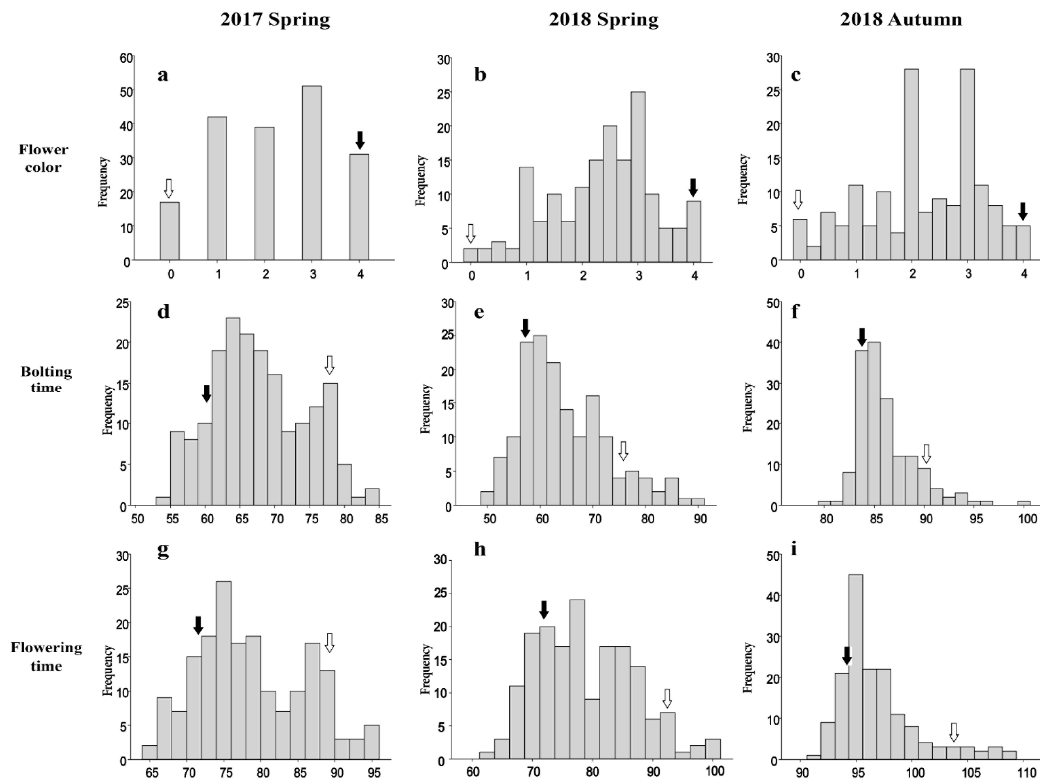
Figure 2. Frequency distribution of the flower color, bolting time, and flowering time traits in radish populations over two years. ( a , d , g ): frequency distribution of the flower color, bolting time, and flowering time for the F 2 population in spring 2017; ( b , e , h ): frequency distribution of the flower color, bolting time, and flowering time for the F 2:3 population in spring 2018; ( c , f , i ): frequency distribution of the flower color, bolting time, and flowering time for the F 2:3 population in autumn 2018. The trait frequencies were normally distributed. White and black arrows indicate P 1 (‘YR4’) and P 2 (‘YR18’), respectively.